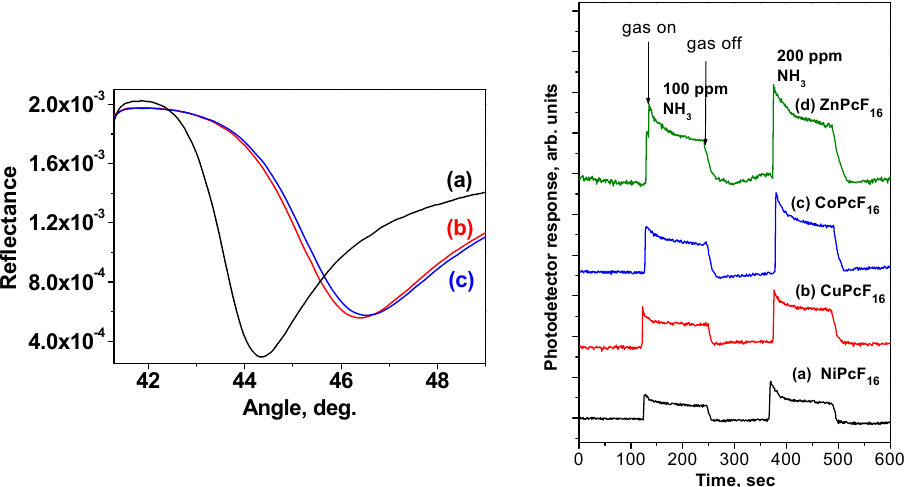
Figure 14. ( left ) Surface plasmon resonance curves for ( a ) pure gold-coated substrate; ( b ) gold/as-deposited CuPcF 16 film; and ( c ) gold/CuPcF 16 exposed by NH 3 gas (200 ppm). ( right ) SPR response curves of MPcF 16 thin films toward gaseous NH 3 (100 ppm and 200 ppm, respectively): ( a ) NiPcF 16 , black; ( b ) CuPcF 16 , red; ( c ) CoPcF 16 , blue; ( d ) ZnPcF 16 , green. The SPR response curves were recorded using the wavelength of 633 nm (He–Ne laser) at a fixed angle of incidence Θ = 44.2. Reprinted from [96] with permission from